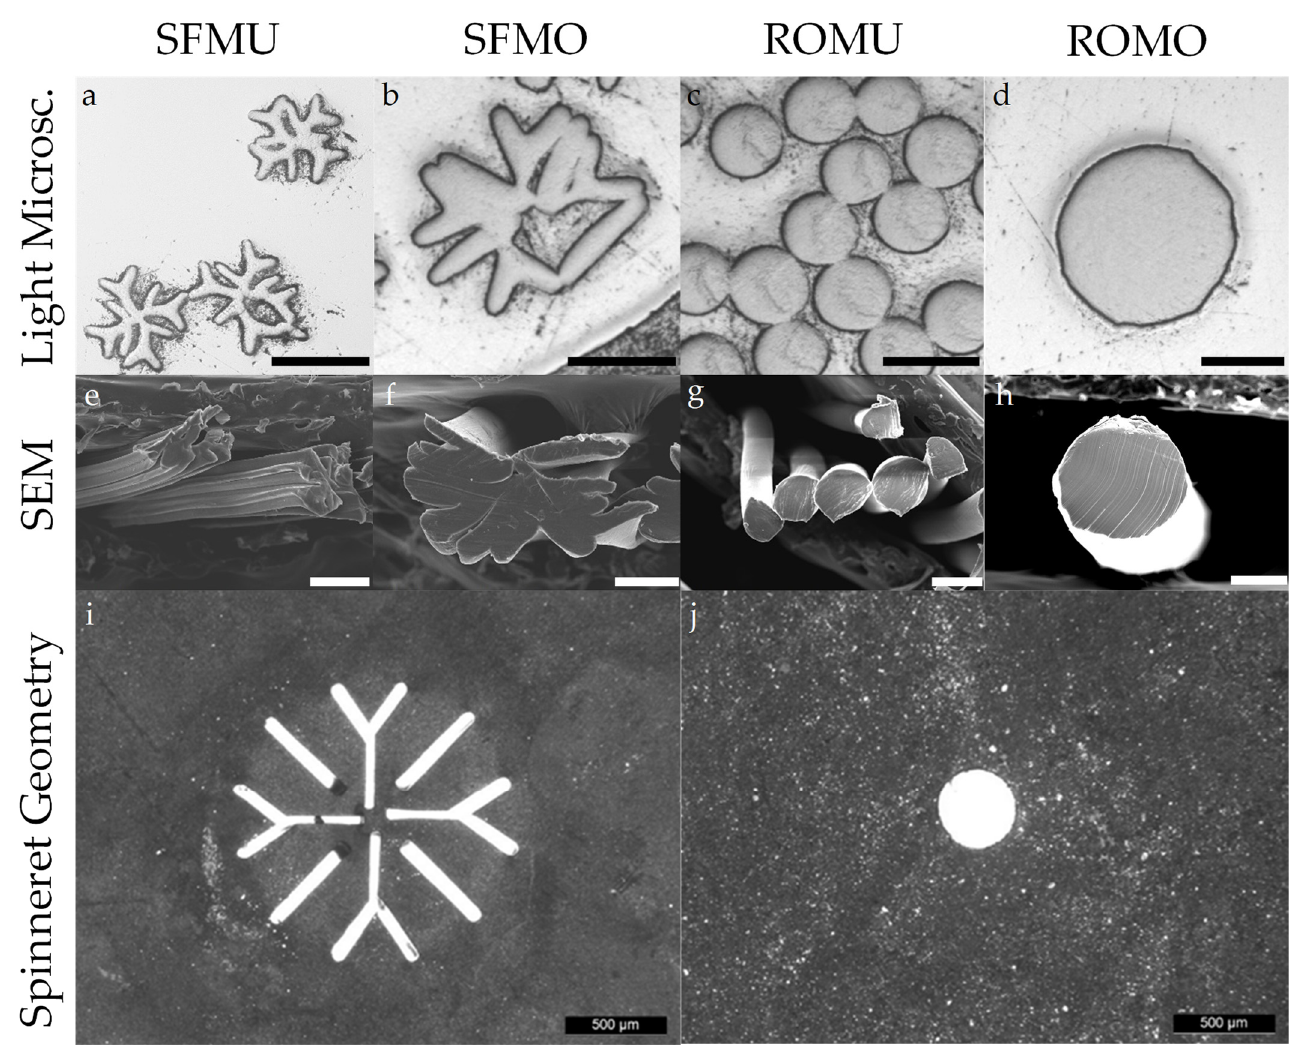
Figure 4. Optical evaluation of the melt spun PCL fibers and spinnerets used. ( a – d , i , j ) Light microscopy and ( e – h ) SEM images of the fiber cross-sections for the four different morphologies as well as ( i , j ) the used spinneret geometries (only monofilament spinnerets displayed). Scale bar SEM/Light Microscopy = 100 µ m, Scale bar Spinneret Geometry = 500 µ m. Table 2. Fiber morphologies used for PBS exposure at 37 ◦